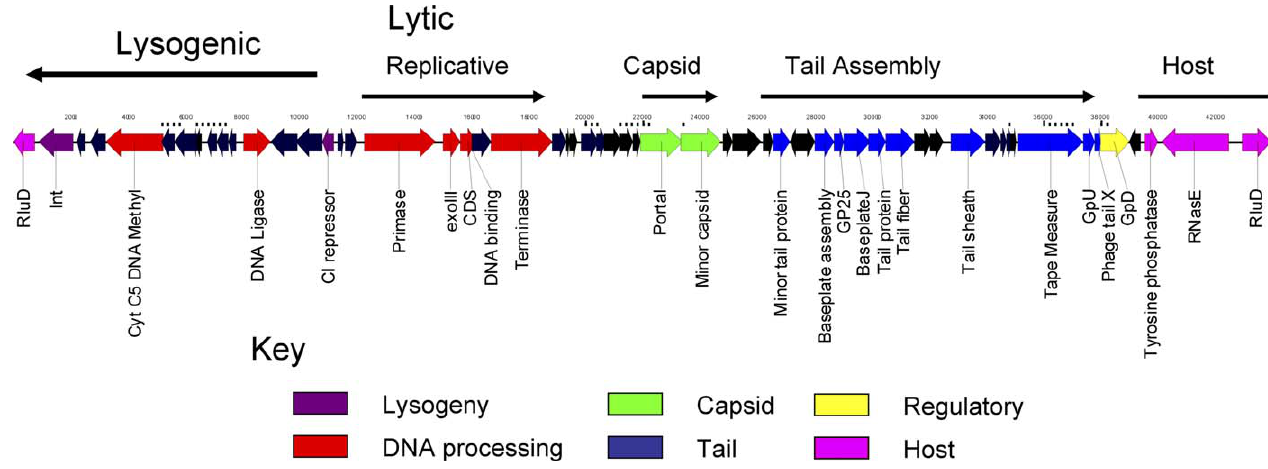
Figure 3. Prophage Genome within the Thiom. crunogena XCL-2 Genome Lysogenic and lytic genes are delineated, as are predicted gene functions. DOI: 10.1371/journal.pbio.0040383.g003